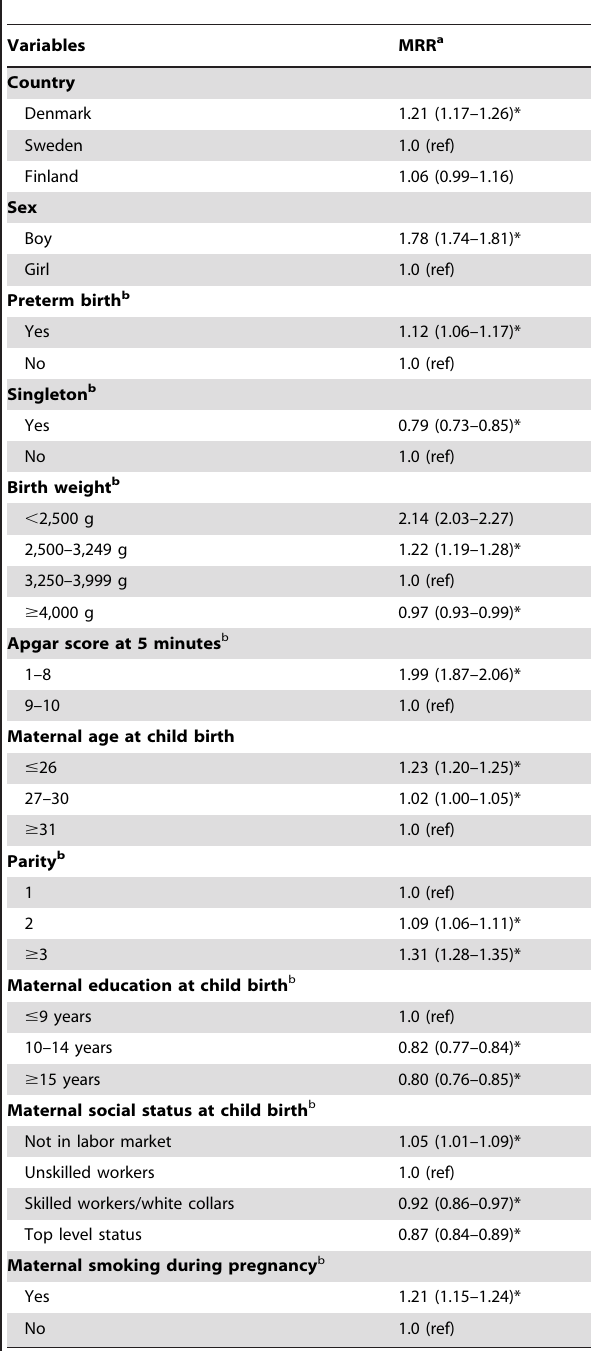
Table 5. Mortality rate ratios among sub-categories of population baseline